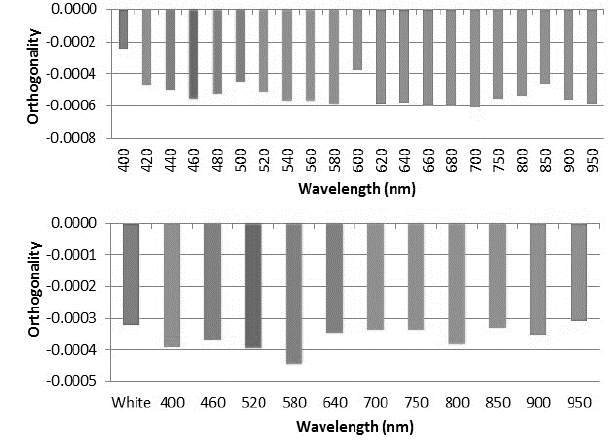
Figure 10. Variation in Orthogonality with Wavelength.